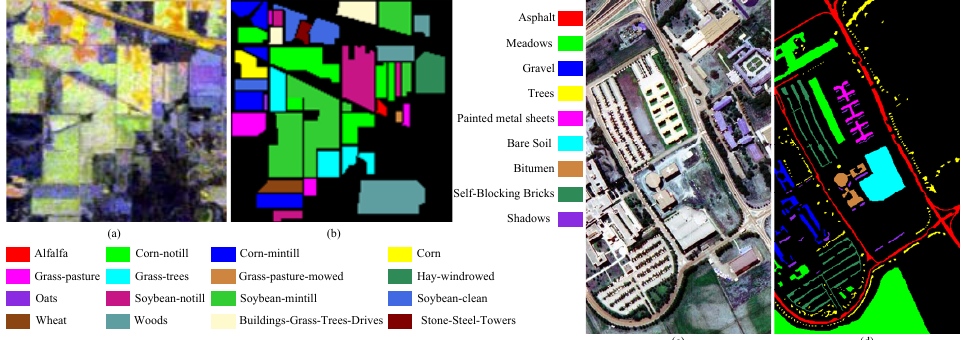
Figure 5. The false-color image ( a ) and the ground truth ( b ) for the IN dataset; The false-color image ( c ) and the ground truth ( d ) for the UP dataset.